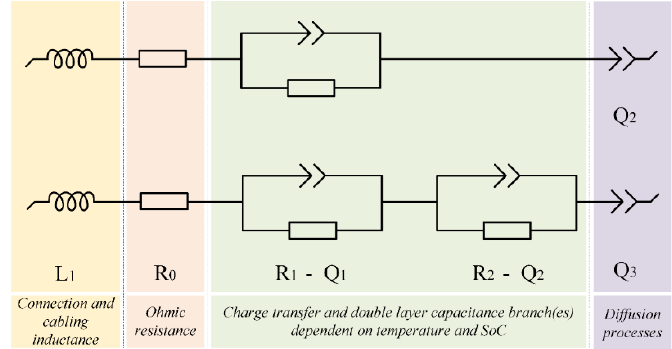
Figure 5. The chosen circuits for modeling the impedance